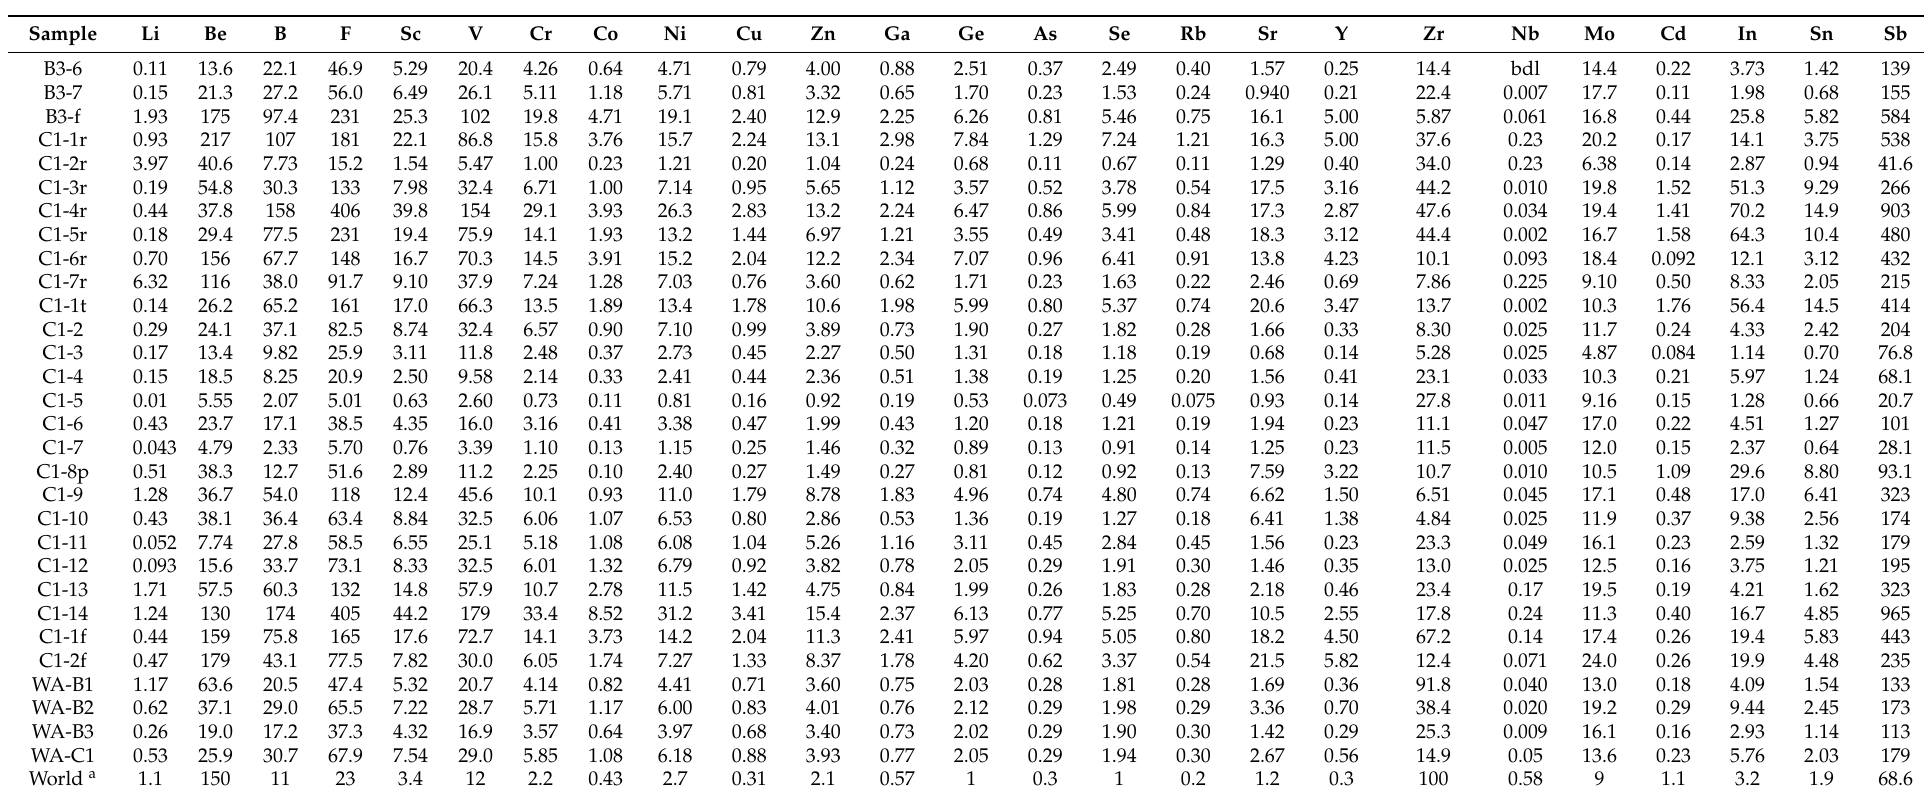
Rows with gray and blue shading are roof and floor strata samples and partings, respectively. bdl, below detection limit. nd, no data. a , averages for world hard coals from Ketris and Yudovich